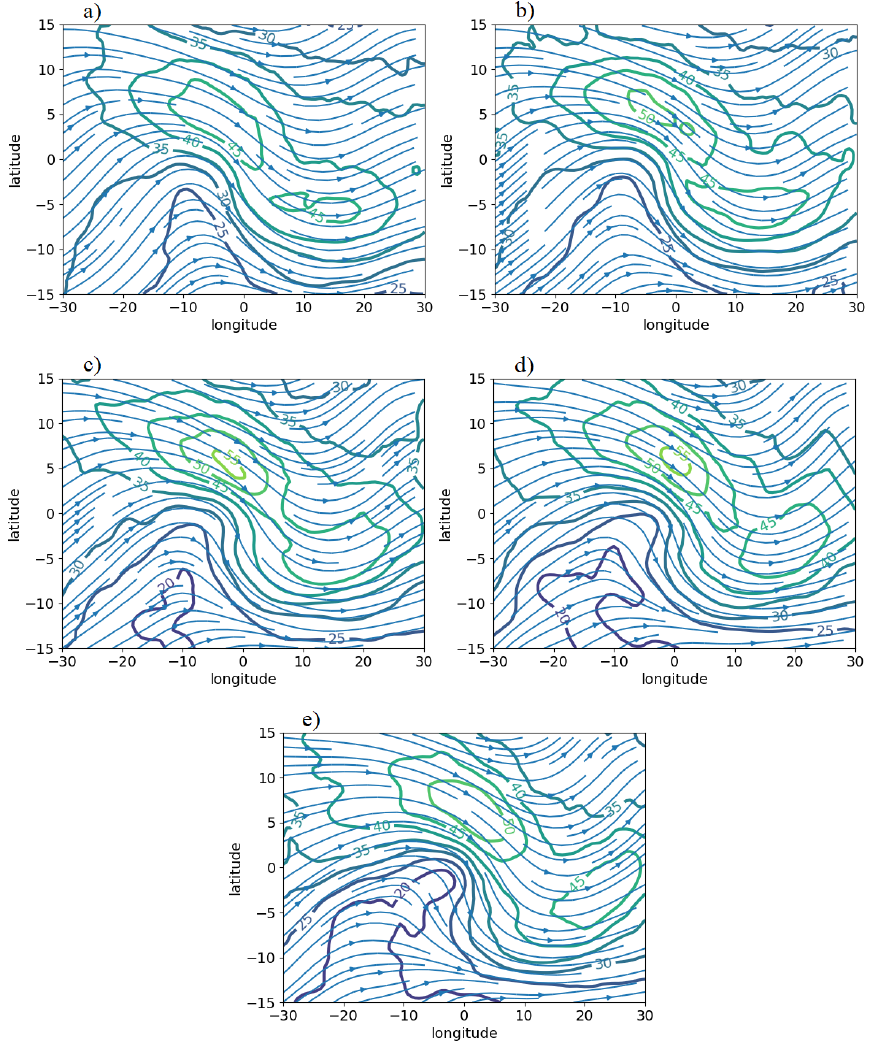
Figure 8. Composite fields of wind magnitude at